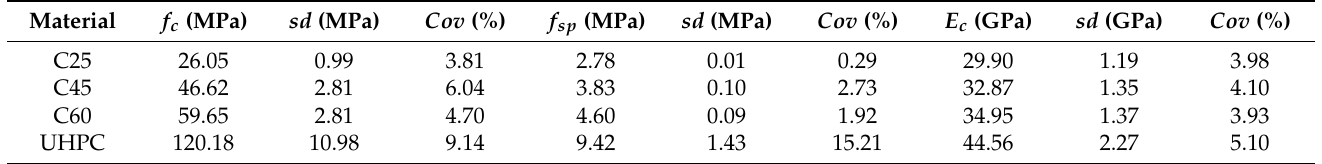
Table 4. Mechanical characteristics of concretes and UHPC.